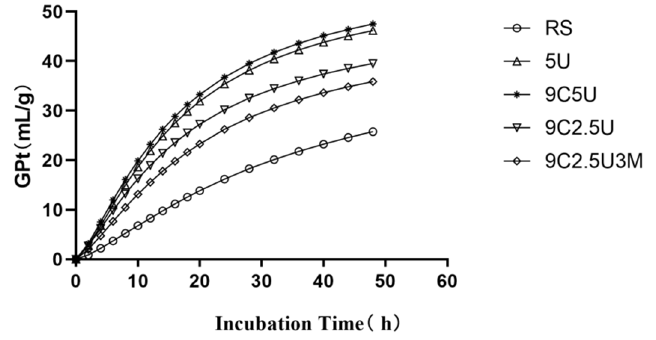
Figure 1. Cumulative gas production curve at 48 h at four ammonia treatments (RS: no additive control; 5U: addition of 5% urea; 9C5U: 9% corn steep liquor + 5% urea; 9C2.5U: 9% corn steep liquor + 2.5% urea; 9C2.5U3M: 9% corn steep liquor + 2.5% urea + 3%